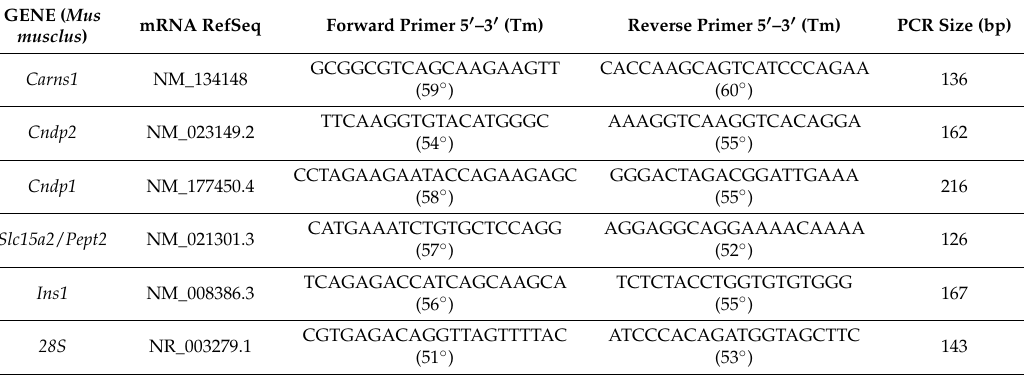
Table 1. For each gene, the NCBI accession numbers of the mRNA reference sequences (RefSeq mRNA; rDNA for the 28S) used for primer design are reported. For each (forward and reverse) primer, the 5’-3’ nucleotide sequence and the melting temperature are reported (Tm). For each mRNA detection, the expected amplicon length is indicated (PCR size) in base pairs